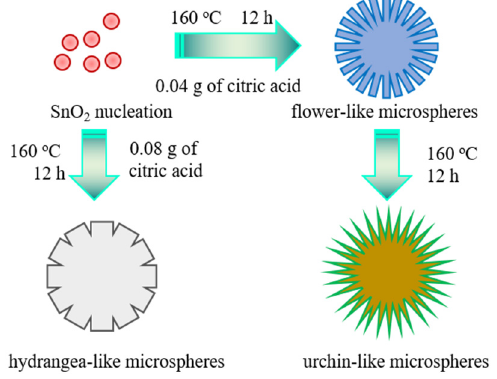
Figure 3. The possible growth mechanism.